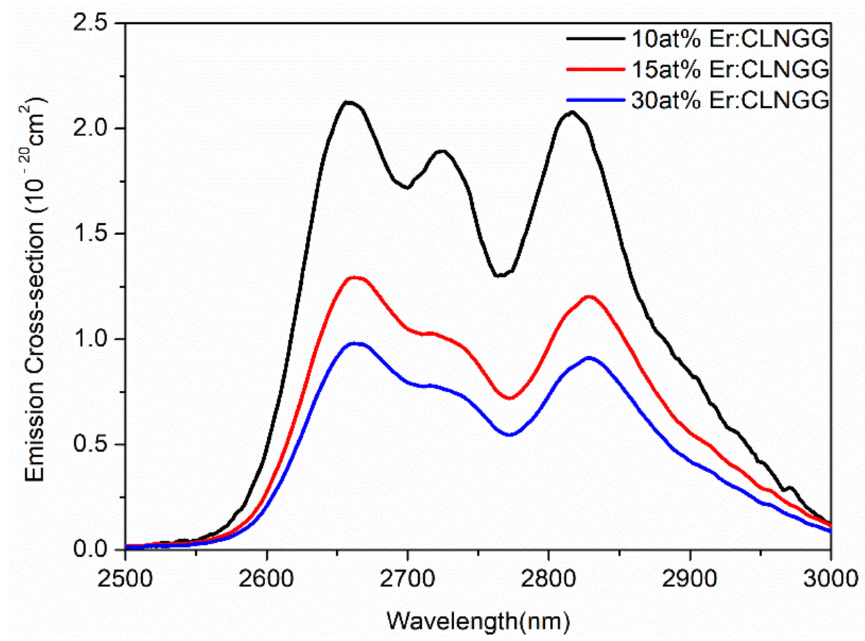
Figure 10. Emission cross-sections for the 4 I 11/2 → 4 I 13/2 transition. Table 4. Spectral parameters of several erbium doped